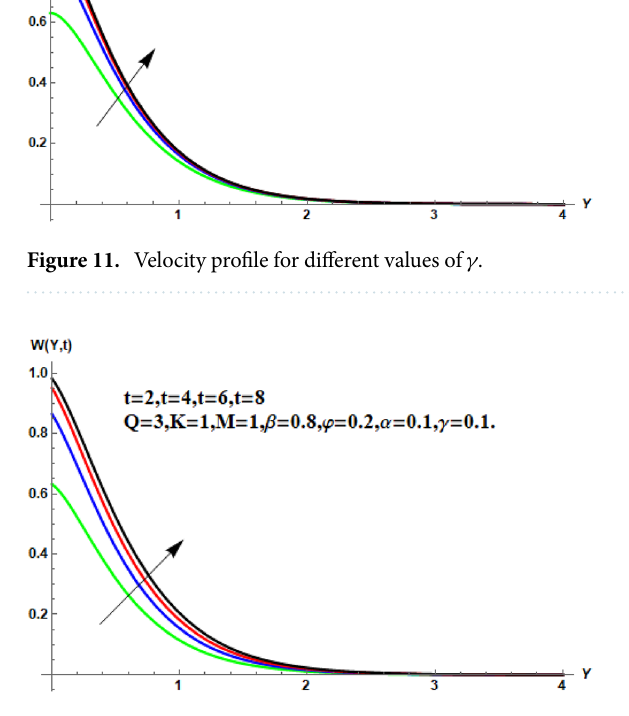
Figure 12. Velocity profile for different values of t .